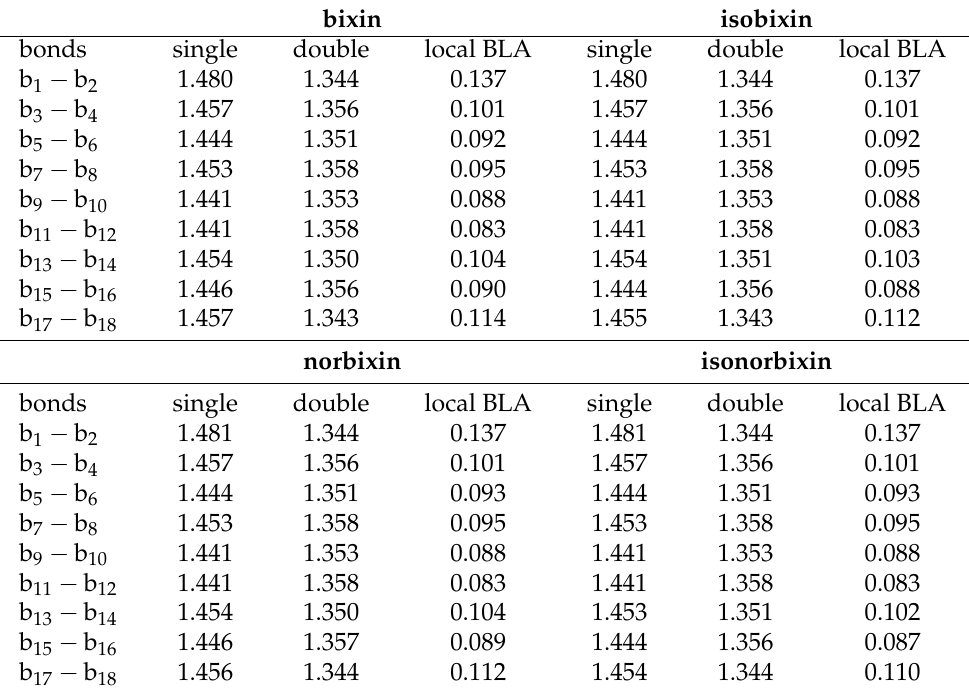
Table A2. Single-double bonds and local BLA values (Å) of the molecular dyes in gas phase. These results were obtained by employing the CAM-B3LYP/6-31+G(d,p) level of theory.